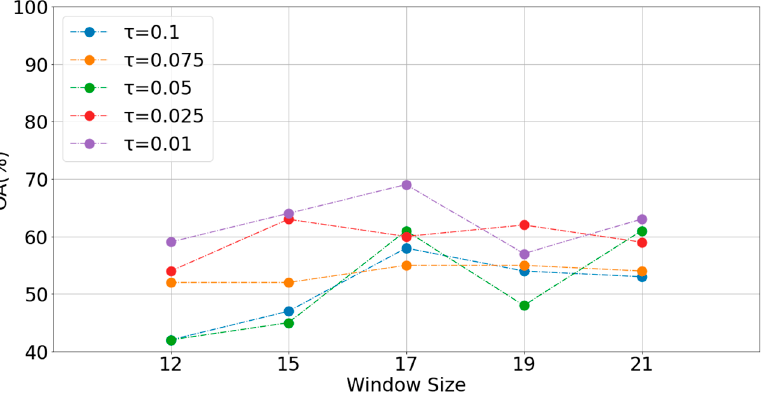
16 of 20 Figure 8. Tree classification maps of models for dataset (3). 3.3. Analysis of Parameters In the M-SSL model, the performance of was affected by some critical parameters, such as window size and temperature. In the experiment, τ denotes temperature, which was set to 0.01, 0.025, 0.05, 0.075, and 0.1, respectively. Similarly, the sliding window size was set as 12, 15, 17, 19, and 21. The OA of the classification results is recorded on the three datasets of Chapter 2.2 with different parameters. With the above effective parame- ters, from Figures 9–11, the experimental results derived mainly from MAAE and MVAE are significantly better than from them alone. The value of τ only affects the features of the supervised learning models, so features of MVAE and MAAE have no relation with τ . The learning performance of the supervised models in experiment is influenced by τ . From Figure 9, when τ is 0.01, the best results were obtained for tree classification with the M-SSL model. In addition, the performance of MVAE and MAAE for feature learning is improved